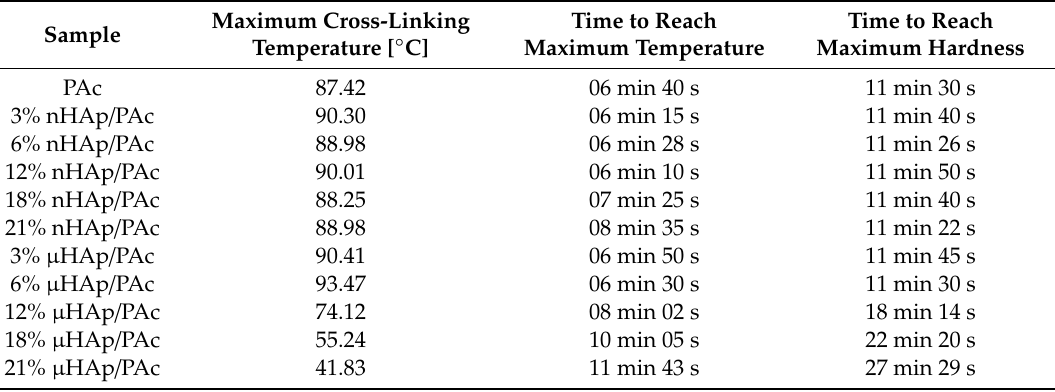
Table 2. Results of the cross-linking reaction temperature and time measurements as well as those of the time needed to attain maximum hardness of the